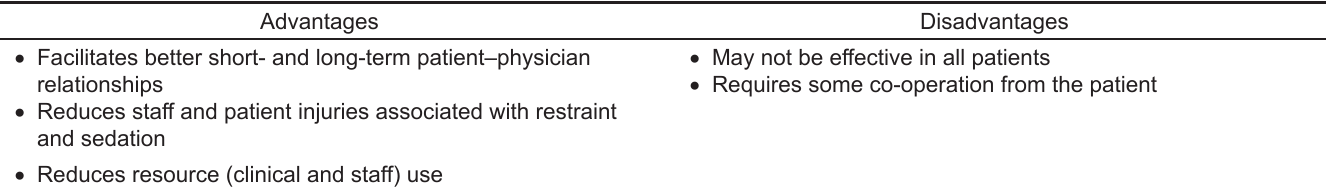
Table 2. Advantages and disadvantages of non-pharmacologic interventions for